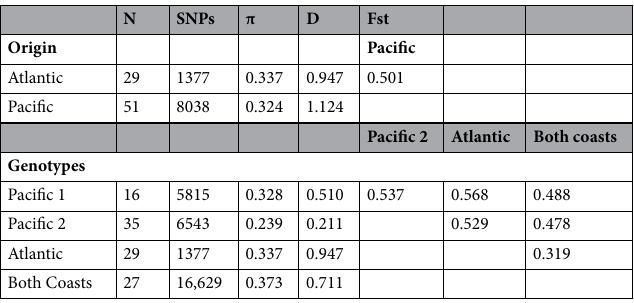
Table 1. Nucleotide diversity (π), Tajima’s D and weighted Fst estimated in the Colombian coconut diversity panel in relation to different genotypes identified. N number of accessions, SNPs number of SNPs, π nucleotide diversity, D Tajima’s D statistics (Weir and Cockerham 1984).